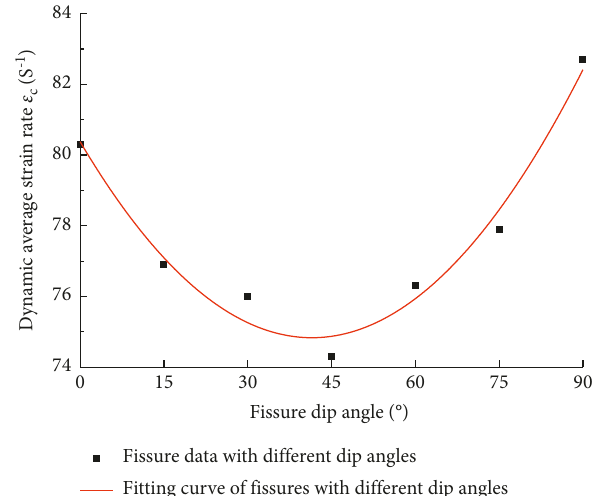
Figure 8: Relationship between the fissure angle and dynamic average strain